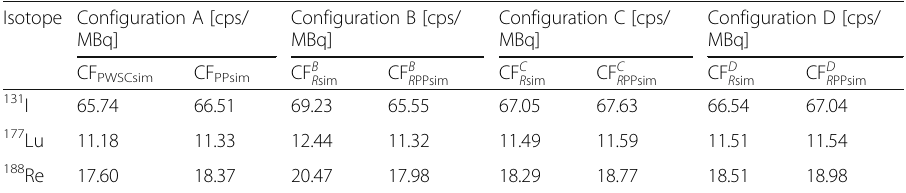
Table 8 Camera CF obtained using simulated data Isotope Configuration A [cps/ MBq]